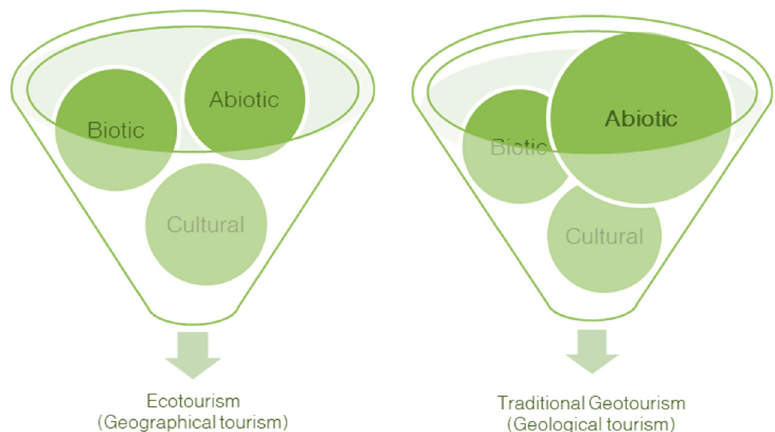
Figure 1. A visualization of the distribution of focus at geotourism sites, depending on the approach practiced [24]. Some geotourism sites provide only slight or nonspecific geoscientific focus to avoid alienating the general public. A means or portal to technical geoscientific information is also needed but not always immediately evident.